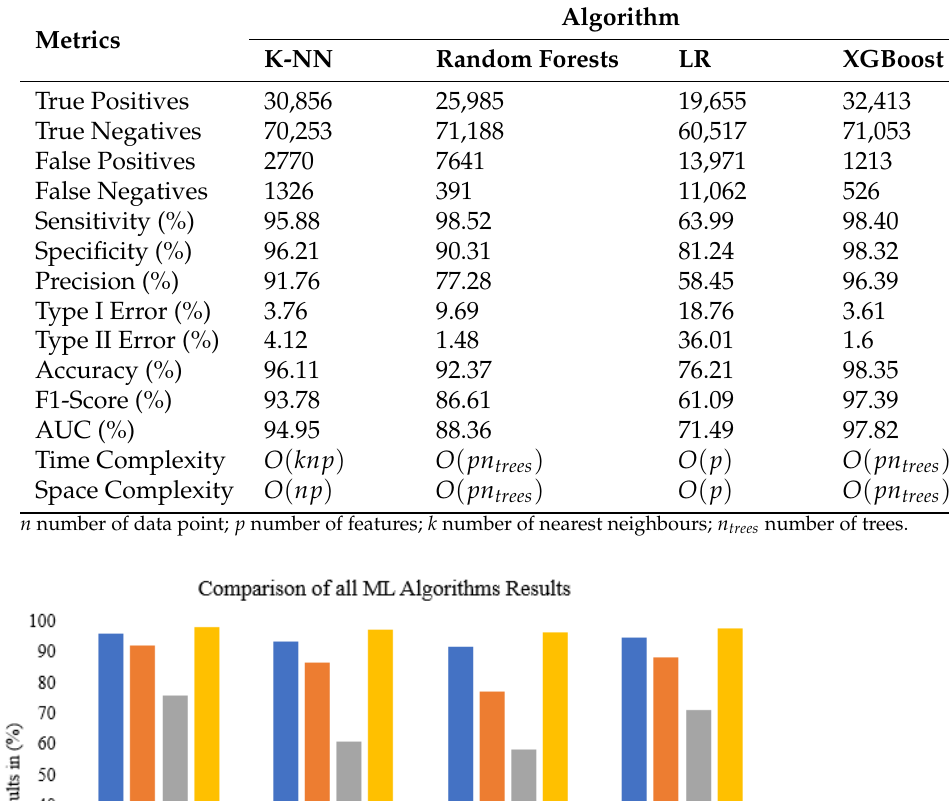
Table 6. Comparison of all machine learning results.